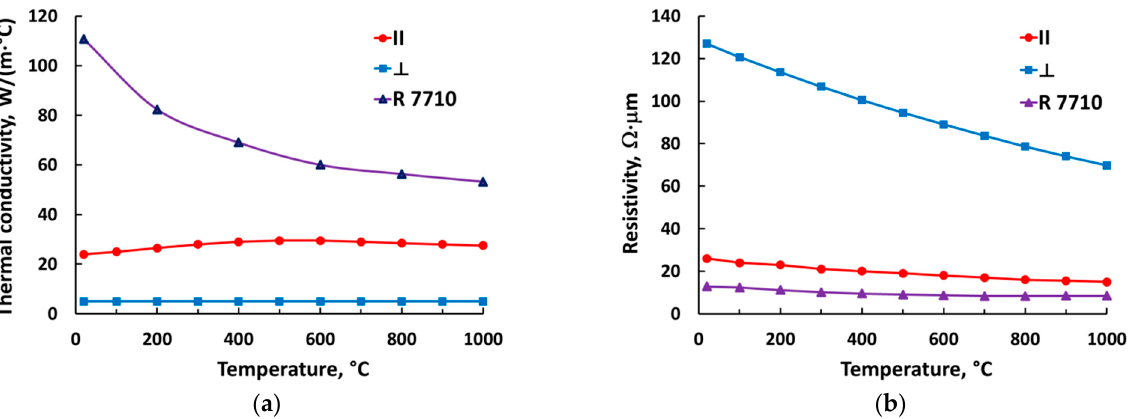
Figure 2. Thermal conductivity ( a ) and electrical resistivity ( b ) of isotropic R 7710 graphite and anisotropic CFRC plate: in plane of carbon fabric ( II ) and in perpendicular direction ( ⊥ ).